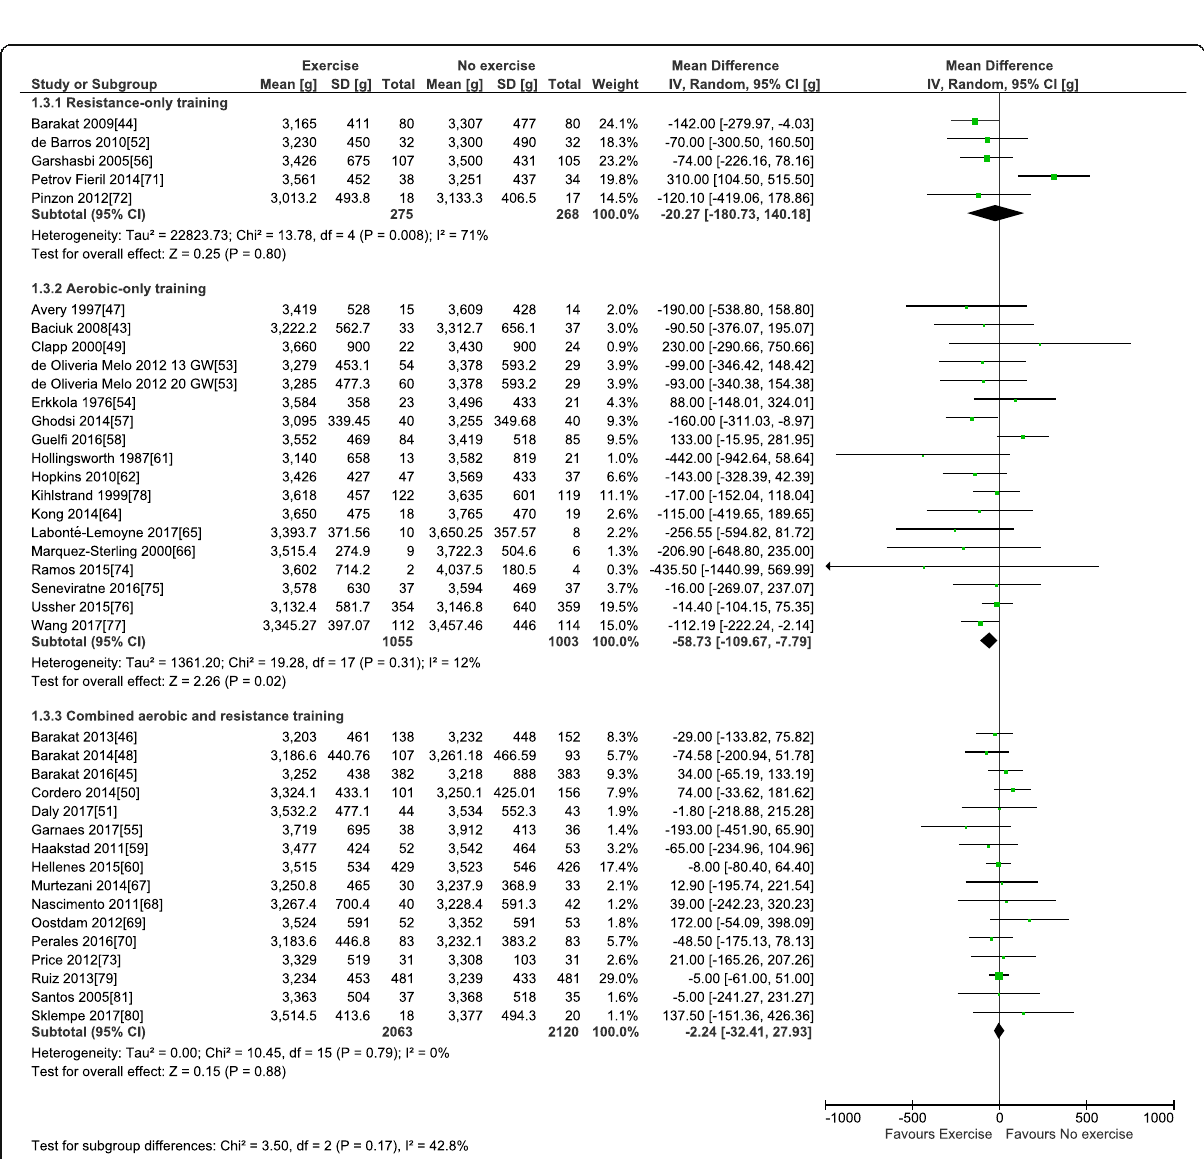
Fig. 4 Forest plot of pooled mean differences for birth weight after exposure to prenatal exercise vs. no exercise; sub-grouping by type of intervention: resistance training only, aerobic training only, or combined resistance and aerobic